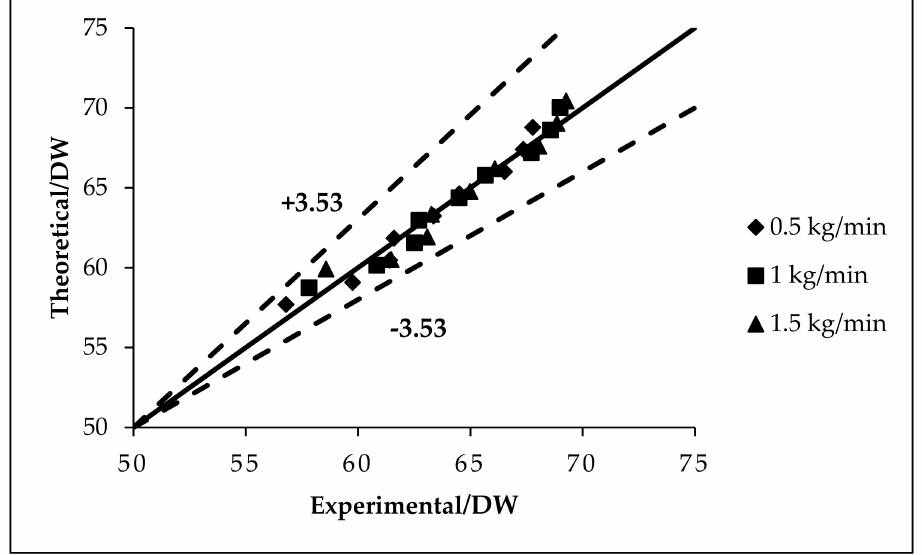
Figure 1. Validation of the present theoretical model with the data available in the literature